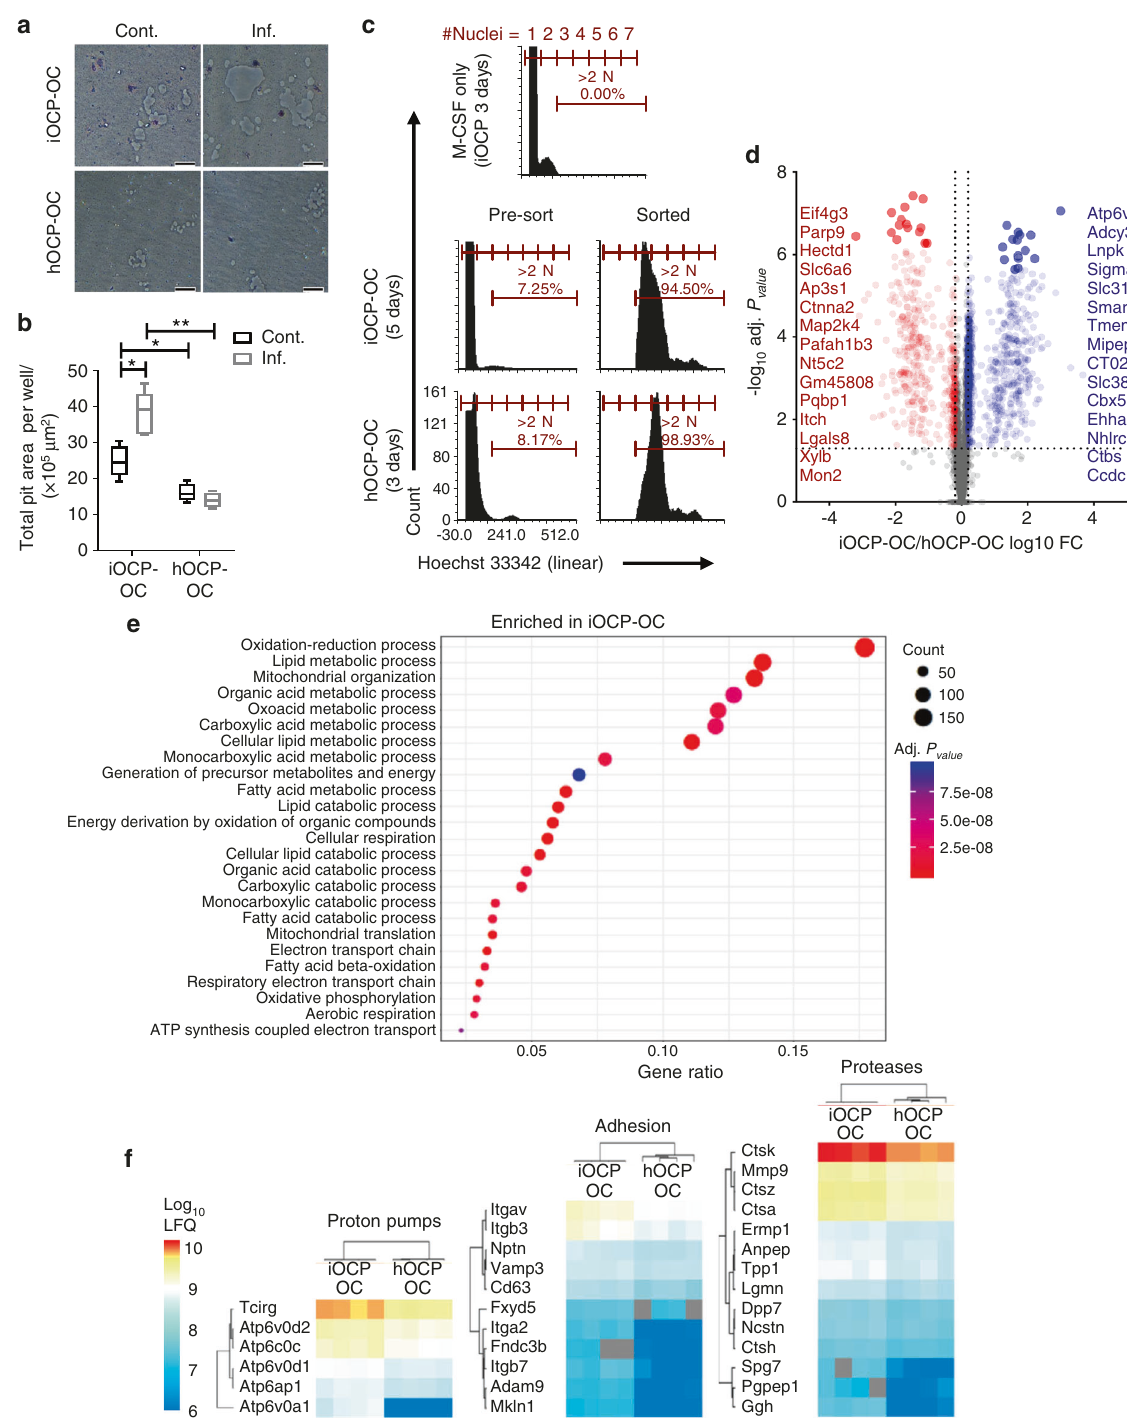
Fig. 6 iOCP-derived OCs are more active and express more resorption-related proteins than hOCP-derived OCs. a Sorted iOCPs or hOCPs (5 × 10 4 ) from the BM of control and in fl amed mice were cultured on Osteo assay surface plates in OC differentiation medium to generate OCs (iOCP- OCs and hOCP-OCs, respectively). The cells were cultured for 10 days until OC exhaustion (bar: 50 µm). b Total pit area per well represents the total resorption potential of a fi xed number of precursors. n = 5 for each group, representative results for three independent experiments. Line: median, box: 25th – 75th percentile, whiskers: range. * P < 0.05, ** P < 0.01 (Mann – Whitney test and Holm multiplicity correction). c hOCPs and iOCPs sorted from the BM of in fl amed mice were cultured for 3 and 5 days, respectively, with RANKL and recombinant M-CSF to generate iOCP- OCs and hOCP-OCs. The cultures were harvested, and mature OCs were sorted as cells with more than two nuclei identi fi ed by Hoechst 33342 staining. The threshold was set according to iOCPs cultured with only M-CSF for 3 days. d Top 15 differentially expressed proteins between iOCP-OCs and hOCP-OCs. e Enriched gene ontology biological process terms among signi fi cant iOCP-OC proteins. hOCP-OCs were enriched in only DNA replication (GO: 0006260). The Benjamini – Hochberg FDR was set to 0.05 for the GO analysis. f Expression heatmaps of OC activity- related proton pumps, adhesion molecules and proteases, which were signi fi cantly more highly expressed in iOCP-OCs. Four biological replicates were used (Limma, FDR =